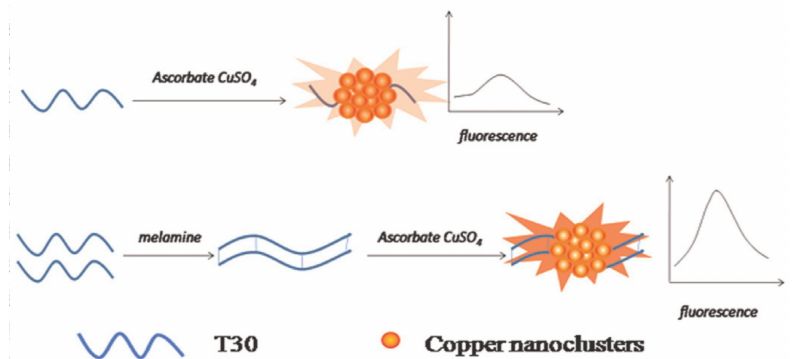
Figure 8. A scheme illustrating the melamine sensing based on the fluorescence enhancement of copper nanoclusters (reproduced with permission from Reference